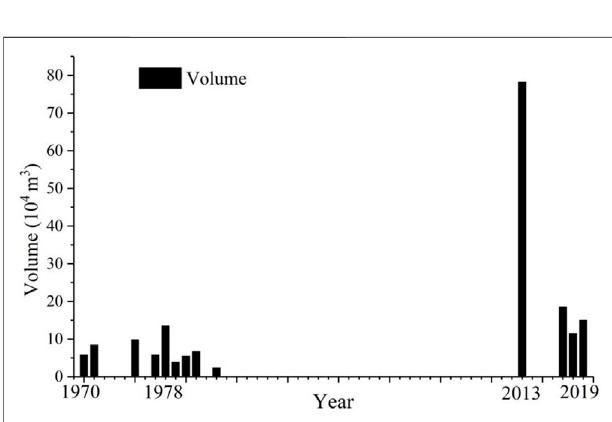
FIGURE 2 | Recorded debris fl ow occurrences and volumes in Qipangou Valley since 1970.